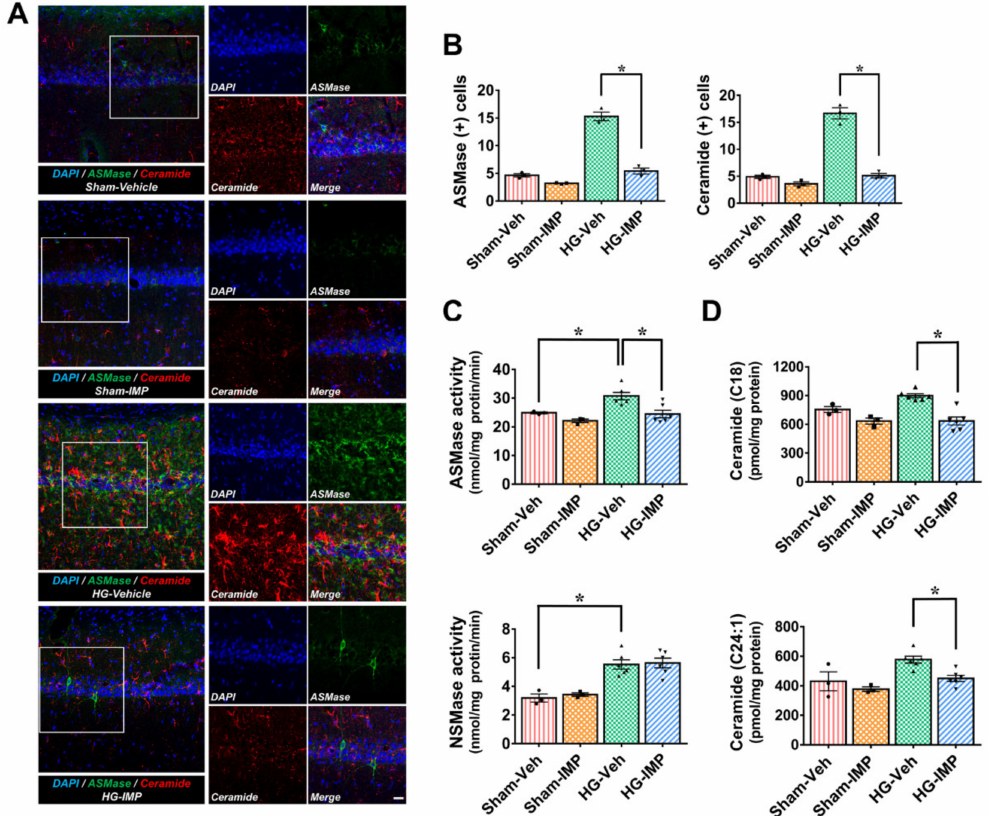
Figure 1. Effects of imipramine (IMP) on hypoglycemia-induced acidic sphingomyelinase (ASMase) activation and ceramide production. Fluorescent images show the effect of imipramine treatment on ASMase activation and ceramide production after hypoglycemia: ( A ) difference in ASMase (green) and ceramide (red) intensity between vehicle- and IMP-treated groups in the vulnerable CA1 region following hypoglycemia. Under normal conditions, neuronal cells maintained an adequate amount ASMase and ceramide, while hypoglycemia caused an excessive rise in both. Scale bar = 10 µ m. ( B ) Bar graph shows the quantification of ASMase and ceramide intensity in the CA1 region. ( C ) The difference in ASMase and NSMase activity between vehicle- and IMP-treated groups in the hip- pocampus following hypoglycemia. ( D ) An analysis of the ceramide content (C18 and C24:1) in the hippocampus. Compared to the sham-operated groups, ceramide contents were found to be increased in the hypoglycemia condition and significantly reduced in ceramide contents when imipramine was administered. Data are the mean ± SEM; n = 3 from each sham group, n = 6 from each